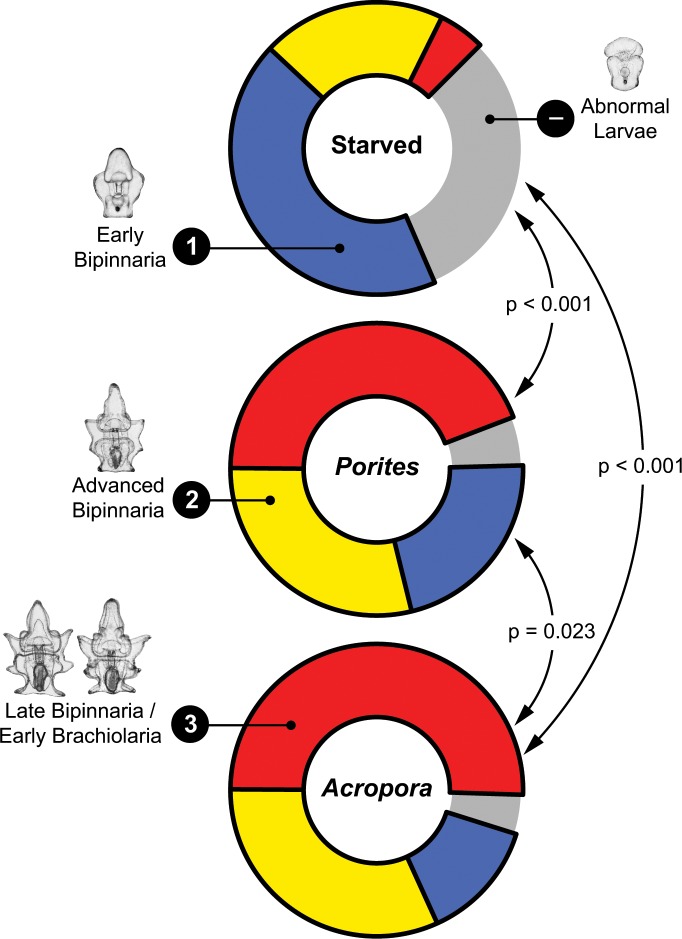
Proportion of larvae under 4 development categories: (1) early bipinnaria, (2) advanced bipinnaria, (3) late bipinnaria / early brachiolaria, and (–) abnormal larvae. Arrows and p-values represent post hoc G-test pairwise comparisons with Benjamini-Hochberg-corrected significance levels.